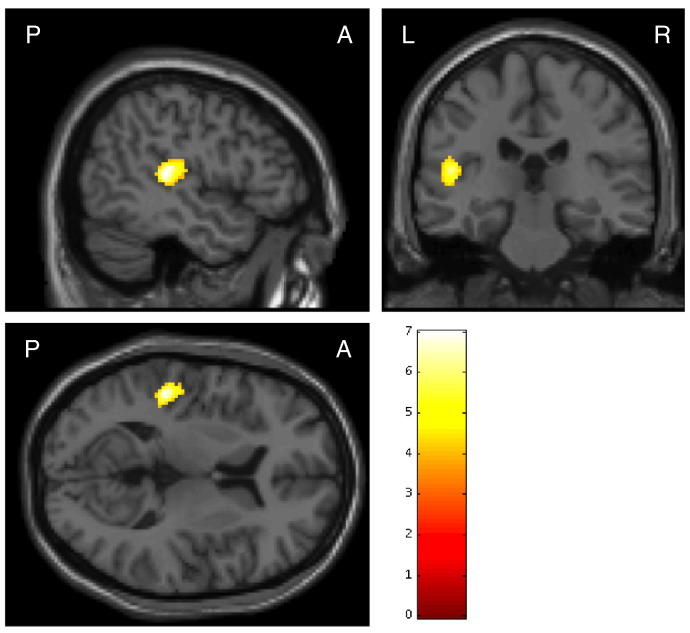
Regions where significant group-by-frequency interactions were revealed by fMRI analyses. Colored bars represent the F-values of the interactions (cluster-level FWE corrected p < 0.05).